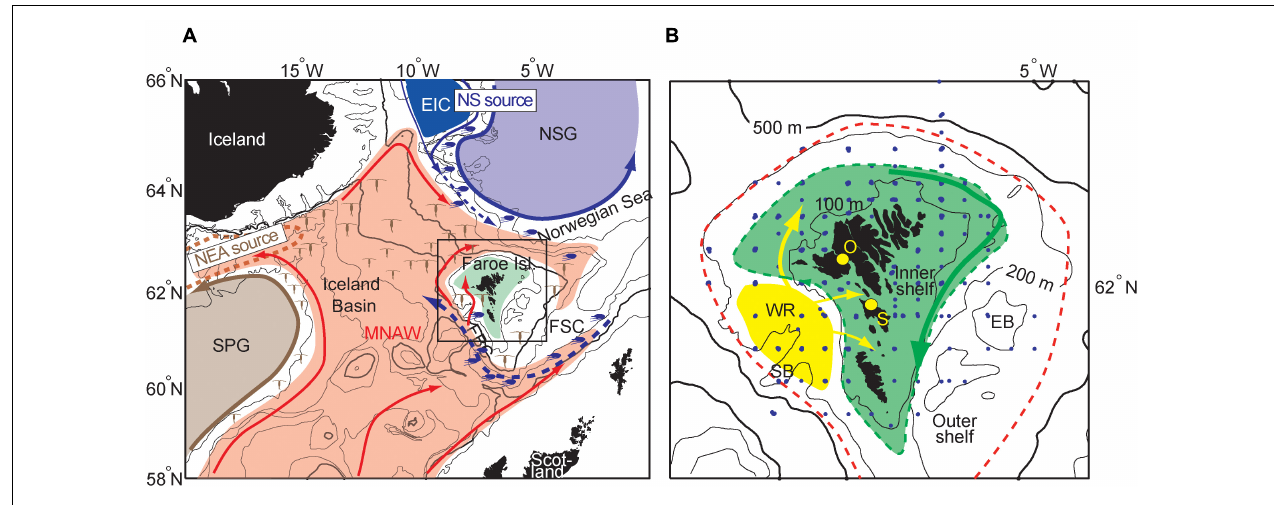
FIGURE 1 | Map of the study area with bottom depth contours. (A) The main warm (red arrows) and cold (blue arrows) currents influencing and carrying C. finmarchicus to the Faroe shelf (green) are displayed. C. finmarchicus originating from the Northeast Atlantic (NEA source) are colored brown, while C. finmarchicus from the Norwegian Sea (NS source) are illustrated in blue. (B) Distribution of C. finmarchicus egg production stations (blue dots) on and around the Faroe shelf 1997–2020. The green dashed line represents the approximate position of the Faroe shelf front (Larsen et al., 2009) separating the permanently mixed inner shelf (green) from the seasonally stratified outer shelf. “O” and “S” denote fixed coastal stations on the shelf. SPG, Subpolar Gyre; MNAW, Modified North Atlantic Water; EIC, East Icelandic Current; NSG, Norwegian Sea Gyre; FSC, Faroe Shetland Channel; WR, Western Region; SB, Skeivi Banki; EB, Eastern